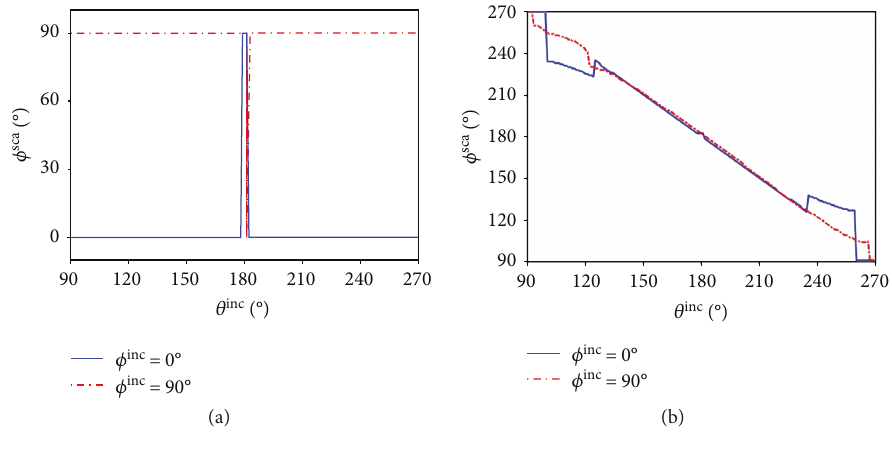
Figure 7: Direction of the maximum RCS ( α = 0